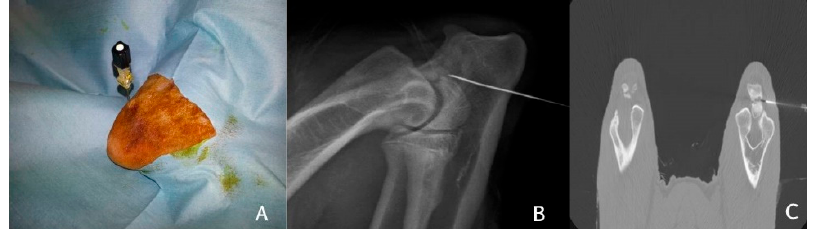
anconeal process ( A ) and an X-ray ( B ) or a CT ( C ) is performed to verify the position of the needle. The stem cells are injected after correct positioning is verified.